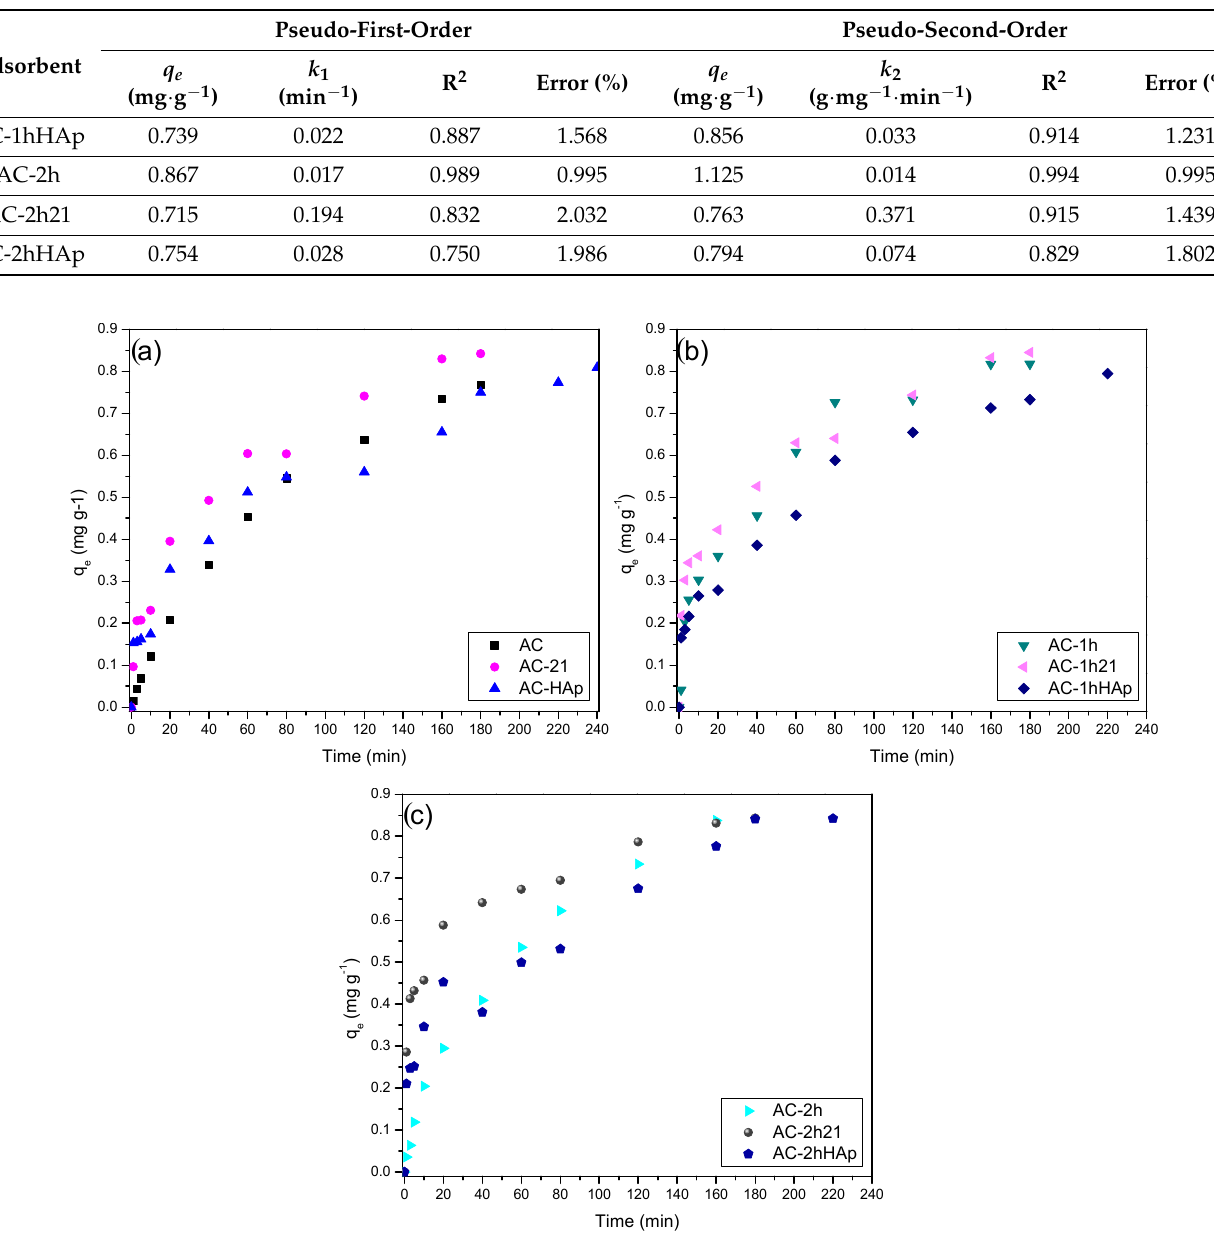
Figure 10. MB adsorption kinetics on different carbon-based materials (conditions: 1 ppm, pH 7, 60 mL volume, and 60 mg of the initial dose of each material). ( a ) Samples without oxidation, ( b ) sam- ples with 1 h oxidation, ( c ) samples with 2 h oxidation.